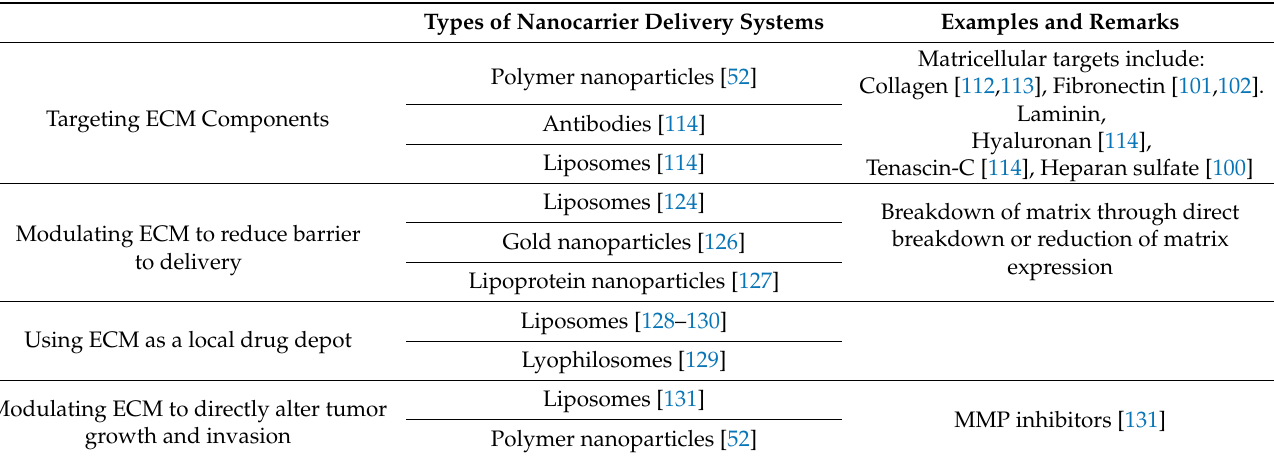
Table 4. Strategies Employing the Tumor